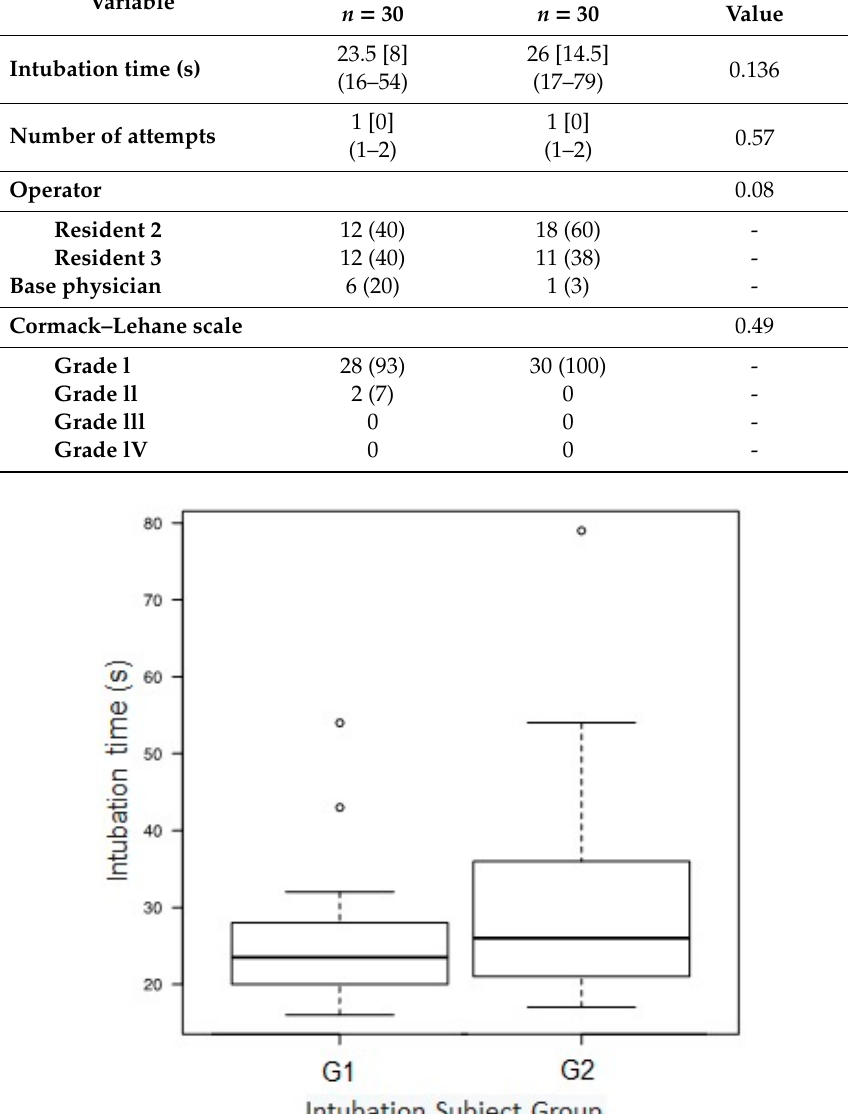
Figure 3. Time taken to perform a successful endotracheal intubation (EI) with VDL Hybrid 1.0 (first group (GI)) and with C-Mac (second group (GII)).